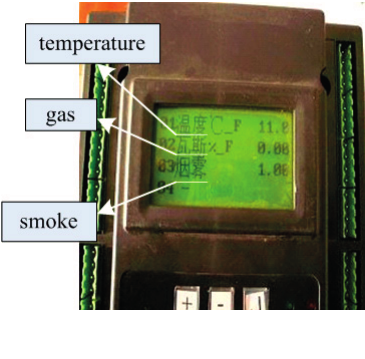
Figure 8. Test results displayed on the